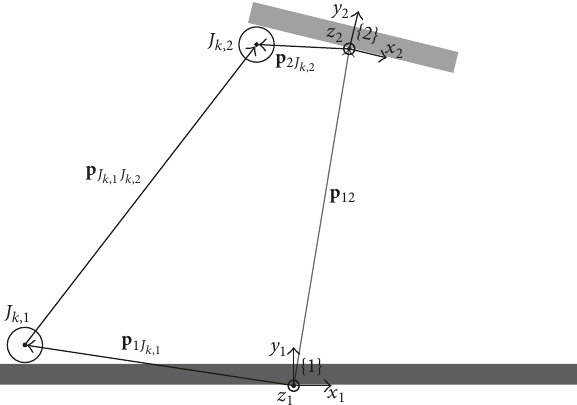
Figure 1: Nomenclature for the description of parallel mechanisms.